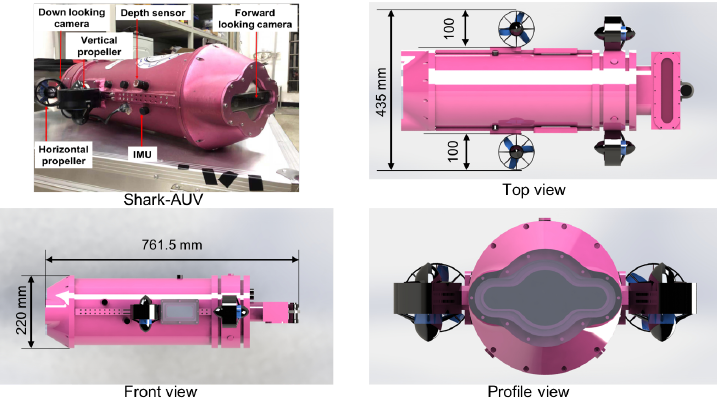
Figure 1. Mechanical structure and configuration of the